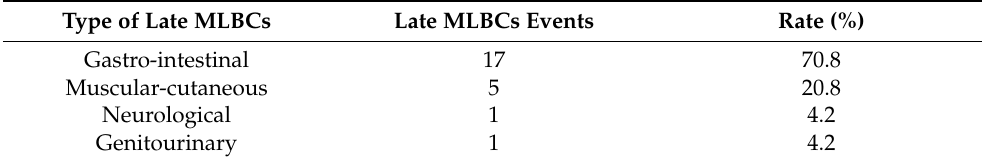
Table 2. Type of late MBLCs.